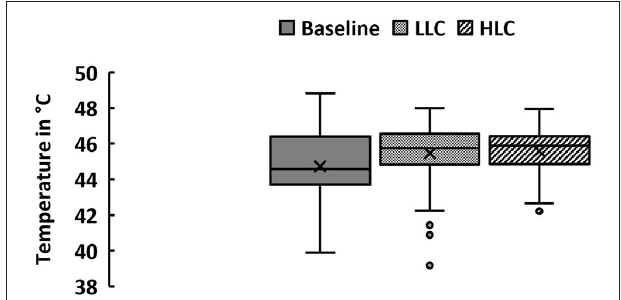
FIGURE 2 | Pain thresholds. Pain thresholds were assessed during a baseline condition (in a static VR environment) and two interactive conditions with a low cognitive load (LLC) and a high cognitive load (HLC) while participants (male = 45, female = 45) were immersed in VR. M ± SD : Baseline: 44.73 ± 1.81 ◦ C, LLC: 45.47 ± 1.53 ◦ C, HLC: 45.58 ± 1.20 ◦ C. Note that the “x” in the middle of the boxplot denotes the mean whereas the horizontal line denotes the median. The whiskers denote the minimum and maximum values. Outliers (i.e., data points that are 1.5 times larger or smaller than the interquartile range) are represented by dots.